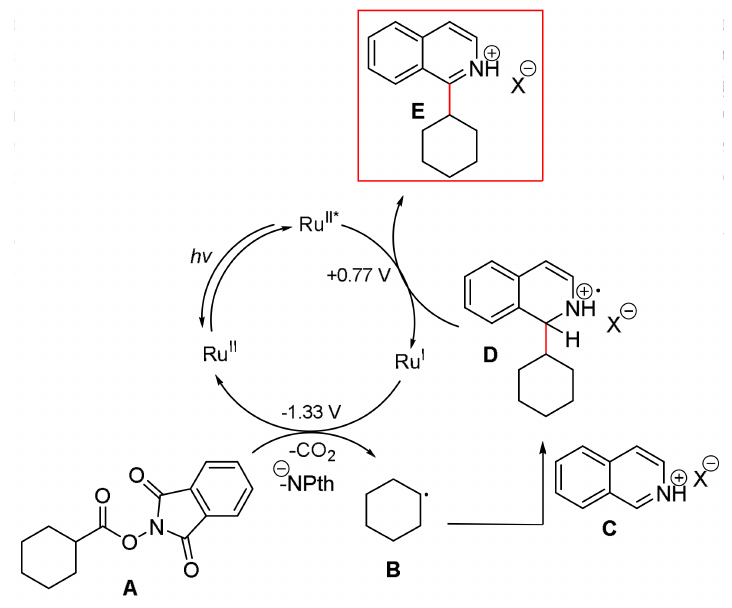
Scheme 2. Proposed mechanism for the photoredox Minisci type reaction.